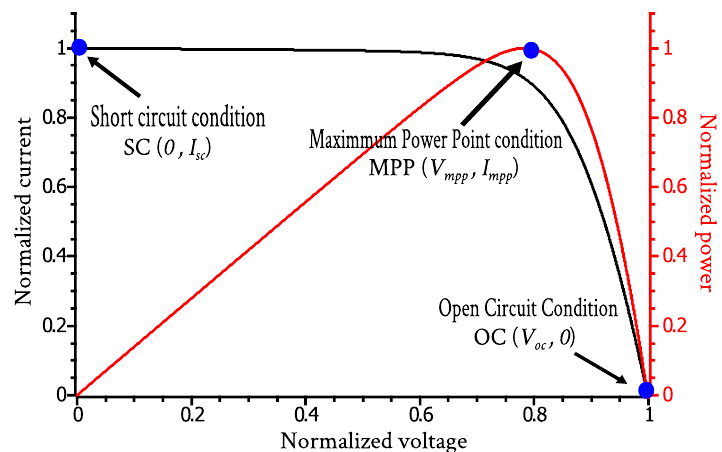
Figure 2. Normalized I-V and P-V characteristics of a solar